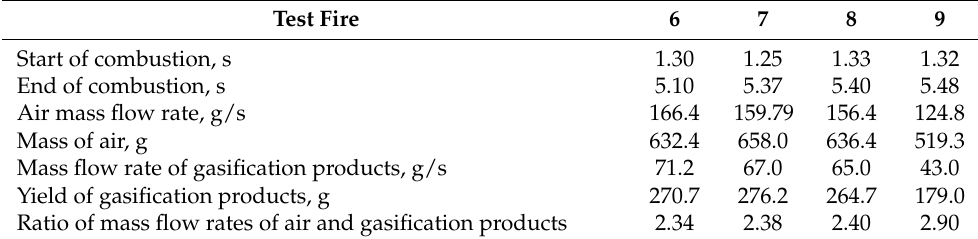
Table 2. Operation parameters of GG at pyro-charge-assisted